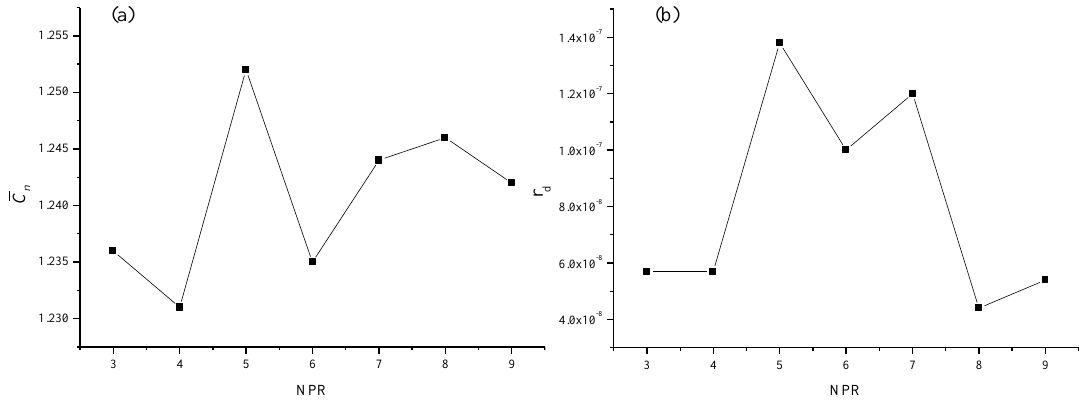
Figure 11. Effect of NPR on the process of deformation. ( a ) Variation of C n and NPR obtained by experiment; ( b ) Variation of r d and NPR obtained by calculation.